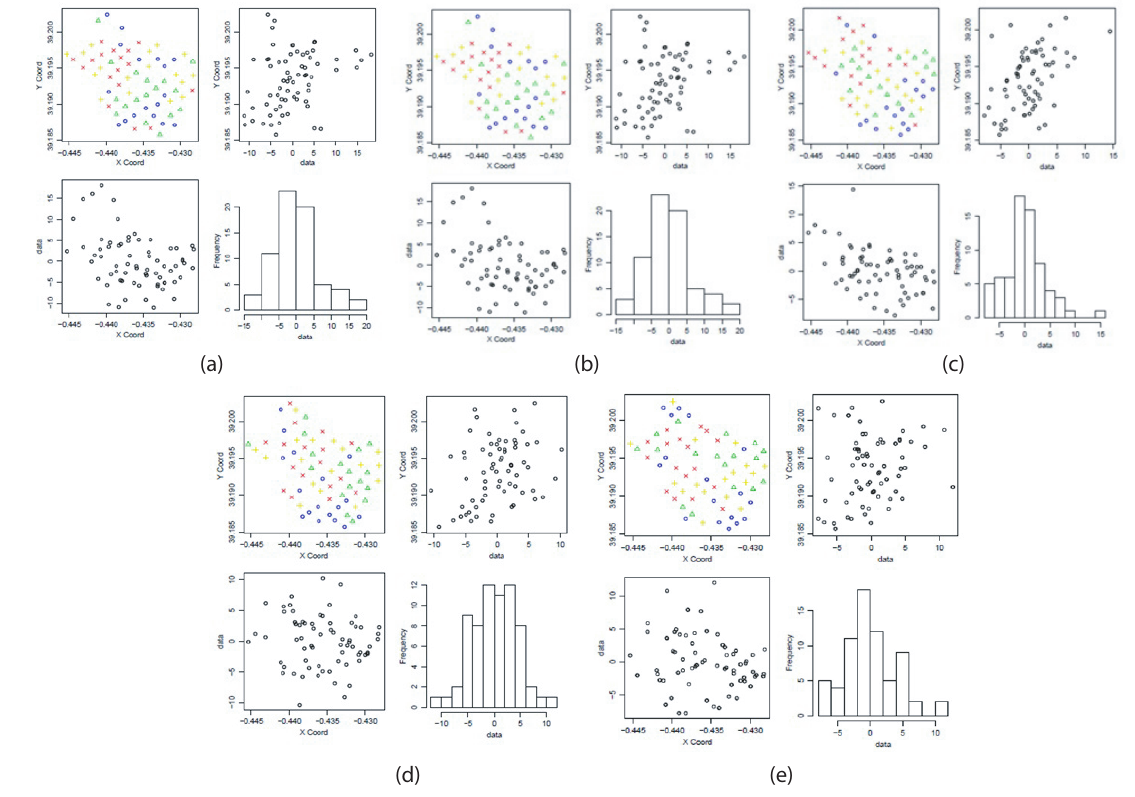
Figure 6. Residuals for different time periods (upper left: spatial distribution of residuals grouped into four magnitude intervals, upper right: residuals according to latitude, lower left: residuals according to longitude, lower right: histogram of residuals). ( a ) period 1; ( b ) period 2; ( c ) period 3; ( d ) period 4; and ( e ) Period 5.